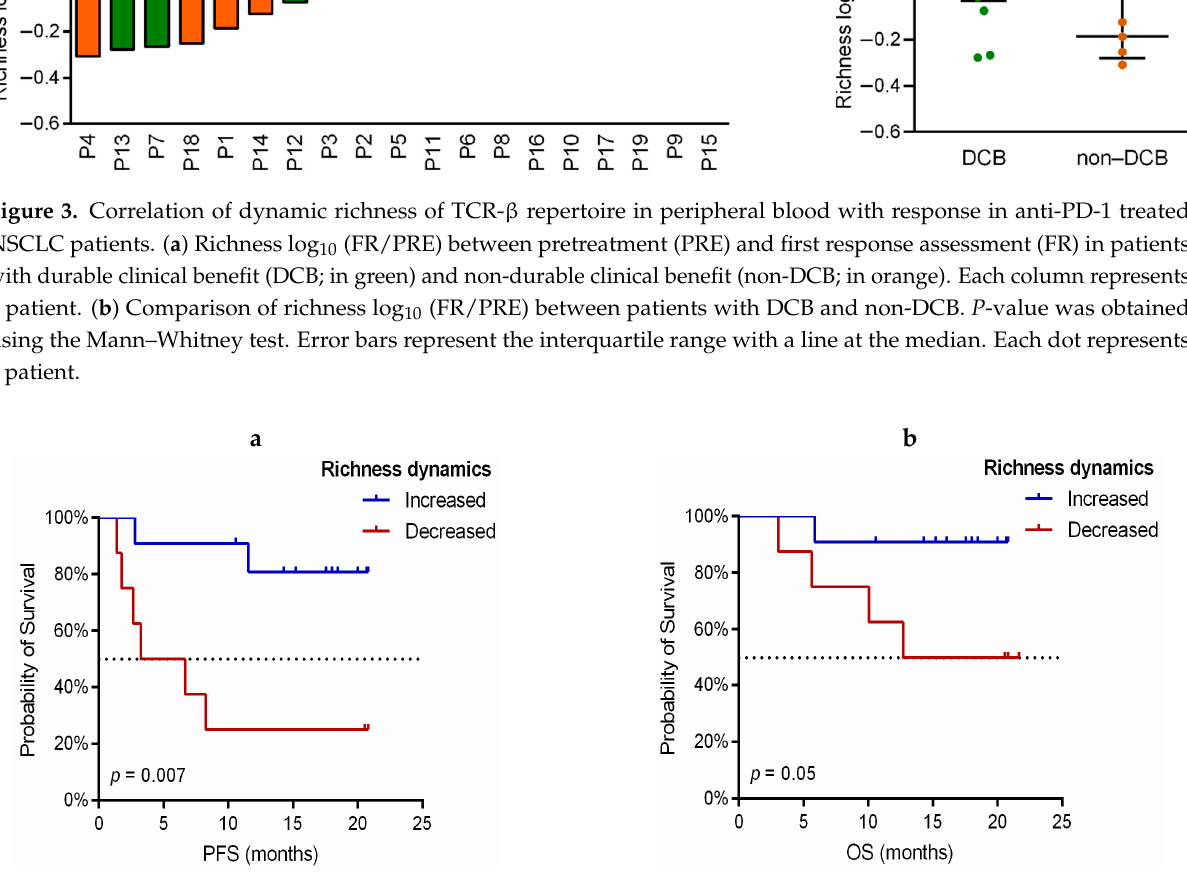
Figure 4. Kaplan–Meier survival curves according to TCR- β richness dynamics in anti-PD-1 treated NSCLC patients. (a) Progression-free survival (PFS) stratified in increased ( n = 11) vs . decreased richness ( n = 8). (b) Overall survival (OS) stratified in increased ( n = 11) vs . decreased richness ( n = 8). P -values were obtained using the log-rank test.